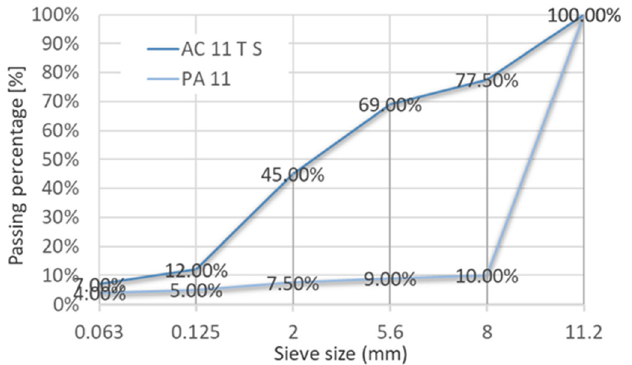
Figure 2. Grading Curve of AC 11 and PA 11.